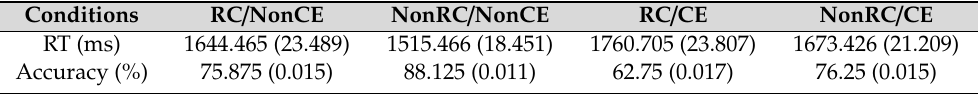
Table 4. The mean RT and mean accuracy for comprehension questions from Experiment